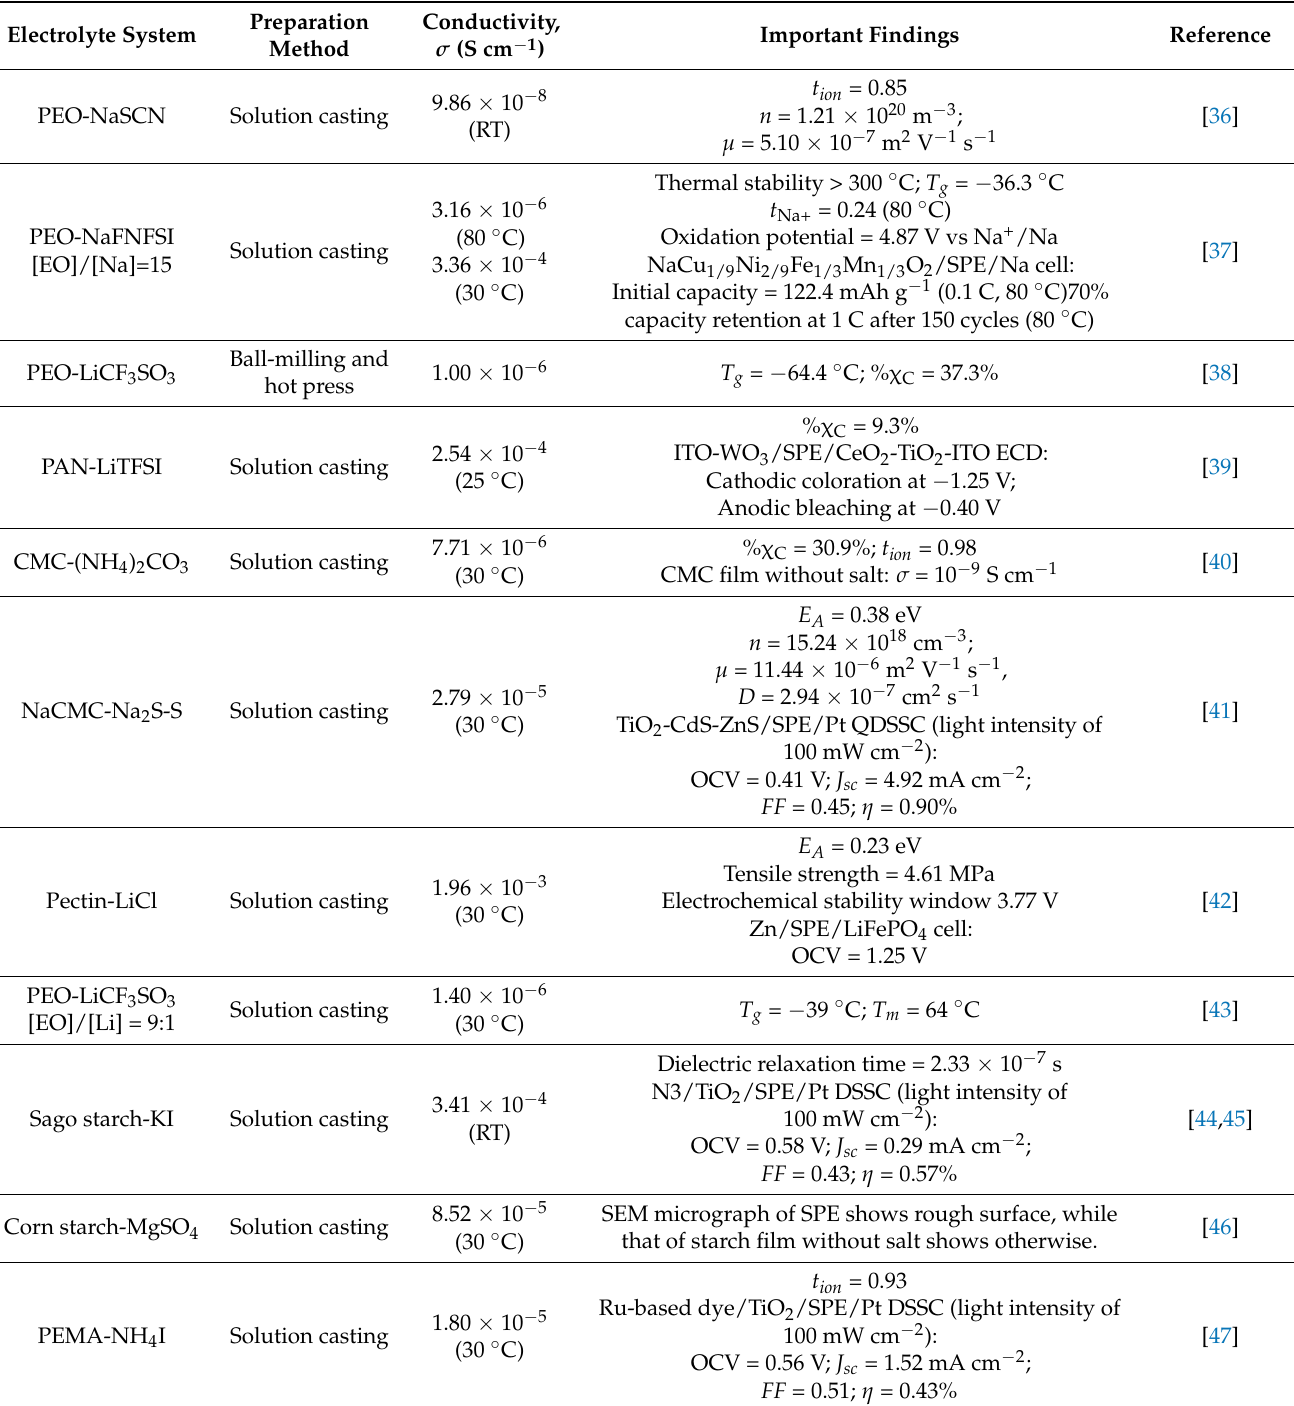
Table 4. Basic SPEs films, along with their conductivity and significant